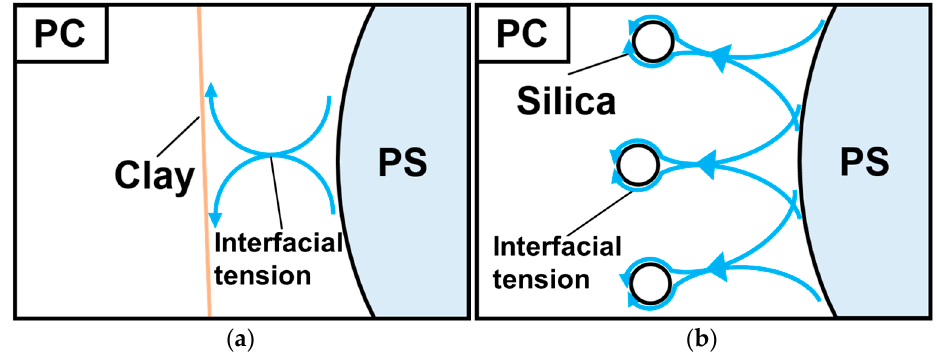
Figure 11. Models of the interfacial tension of plate-like and spherical particles: ( a ) PC/PS/clay; ( b ) PC/PS/silica.